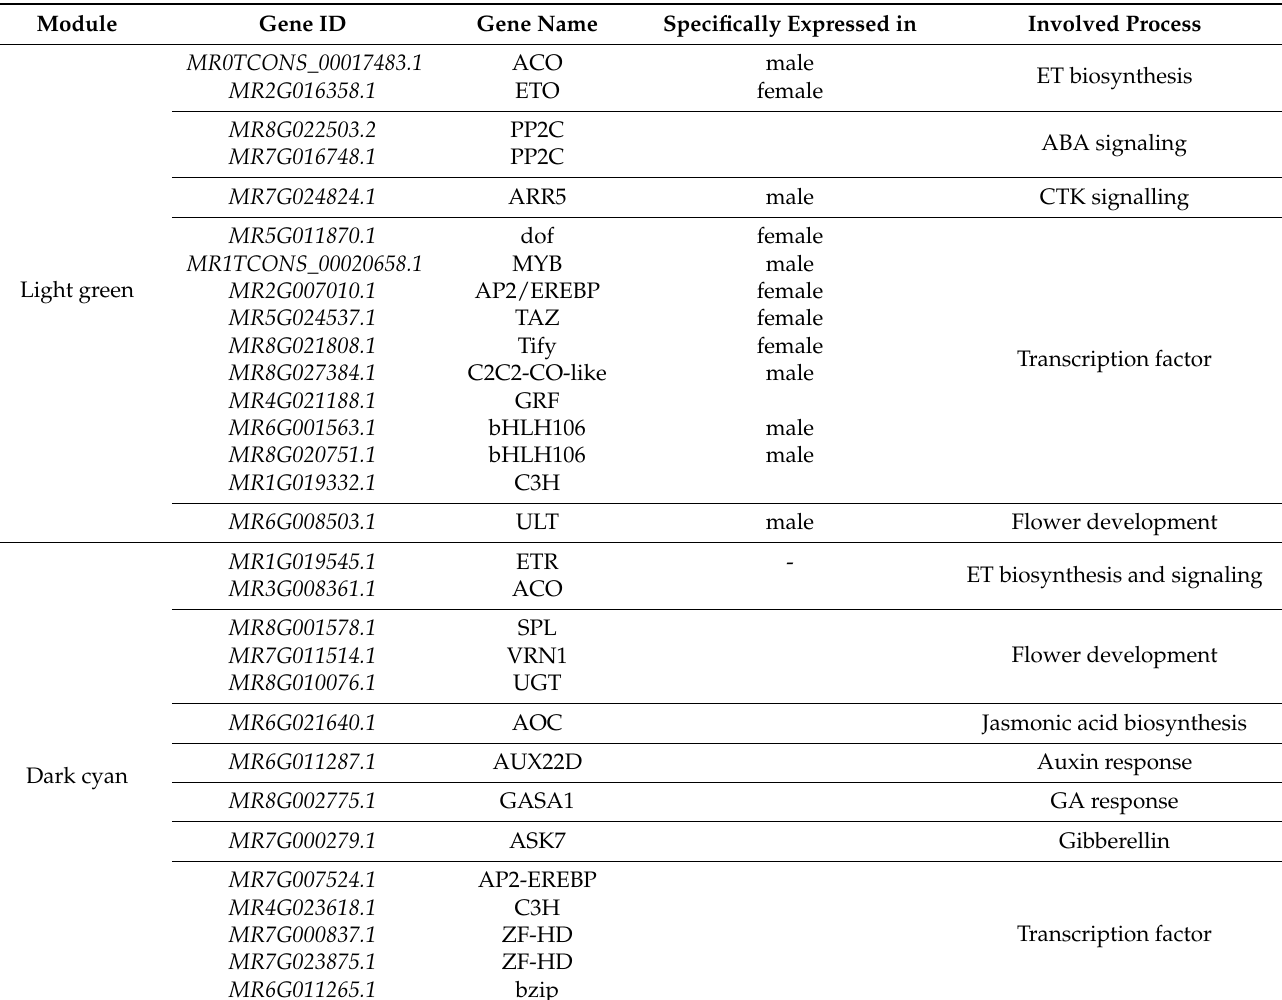
Table 2. List of hormone-related genes, transcription factors and flowering-related genes in two